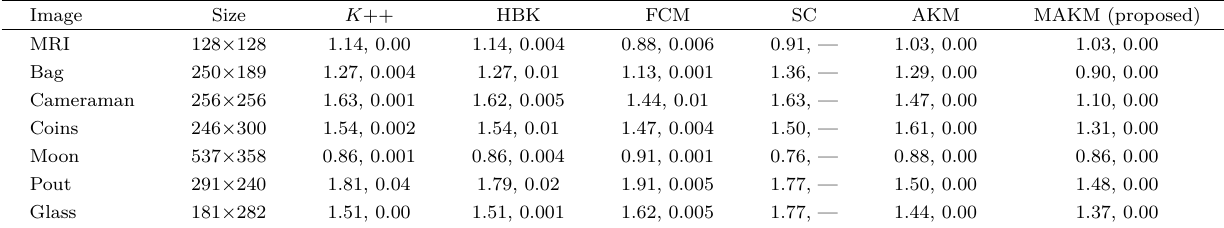
Table 3 Comparison of algorithms in terms of mean RMSE and standard deviation (RMSE, σ )